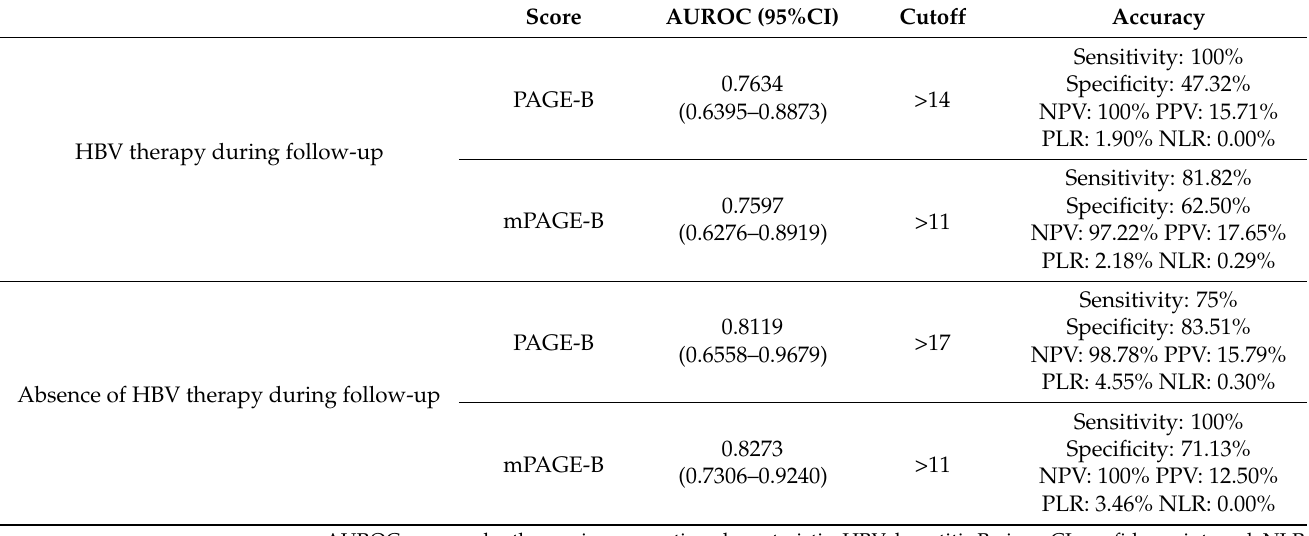
Table 6. Performance of the initial scores stratified by HBV therapy during follow-up.